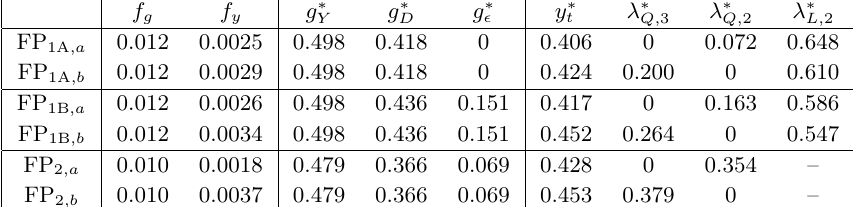
and f for the scenarios investigated in this g y